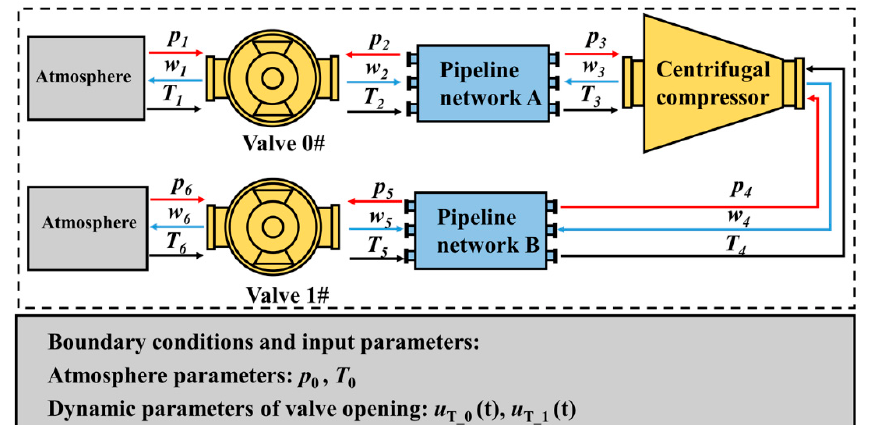
Figure 13. System diagram of the compression system with two throttle valves.